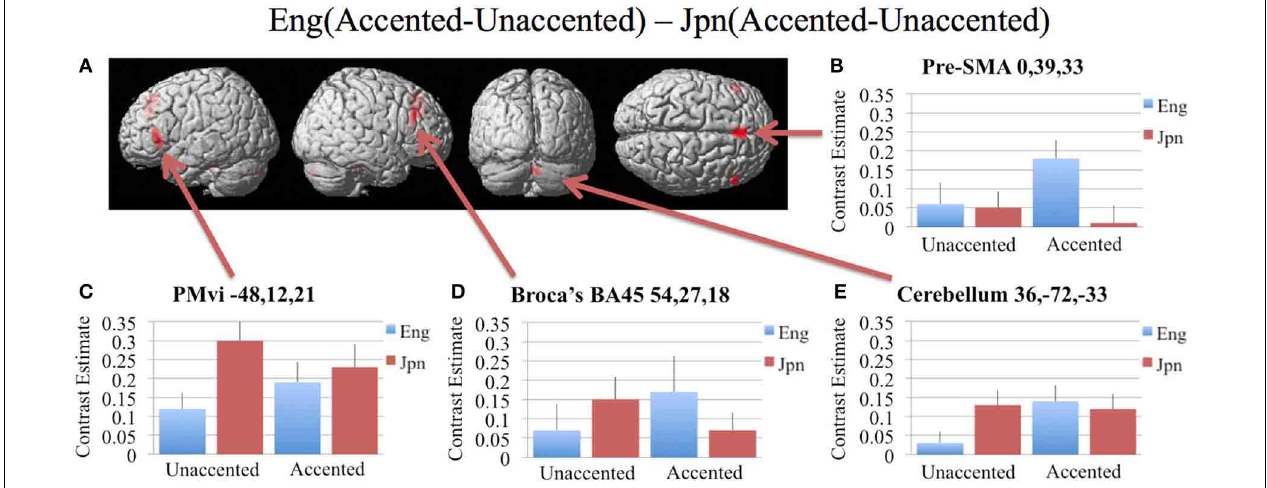
FIGURE 3 | Significant brain activity (thresholded at p < 0 . 001 uncorrected) for the interaction of language group and accent. This contrast focused on the activity involved with perception of foreign-accented productions of a first-language phonetic category. (A) Significant brain activity rendered on the surface of the brain for the contrast of Eng(accented-unaccented) – Jpn(accented-unaccented)